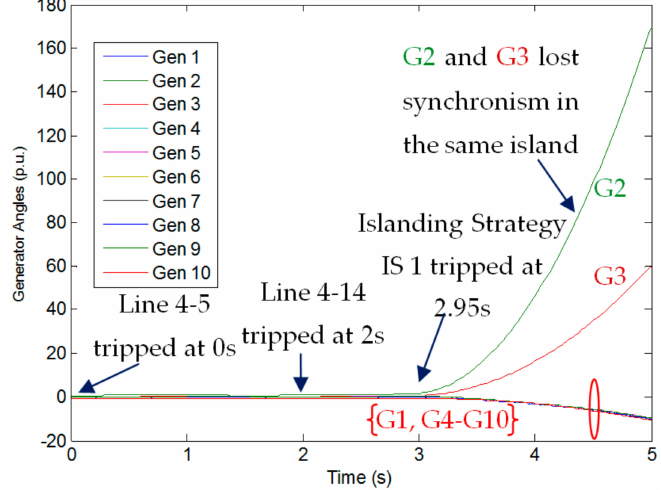
Figure 8. Islanding strategy IS1 applied beyond critical islanding time at 2.95